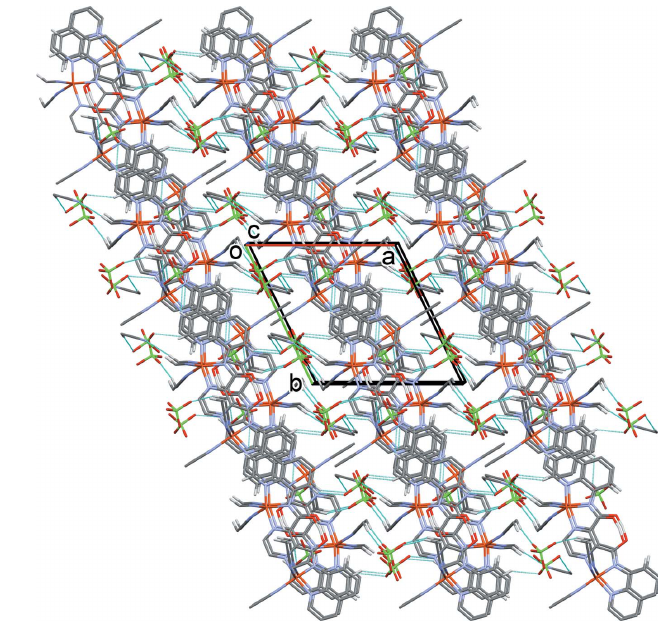
Figure 5 The crystal packing of ligand H 2 L1 , viewed along the a axis. Hydrogen bonds are shown as dashed lines (see Table 1).